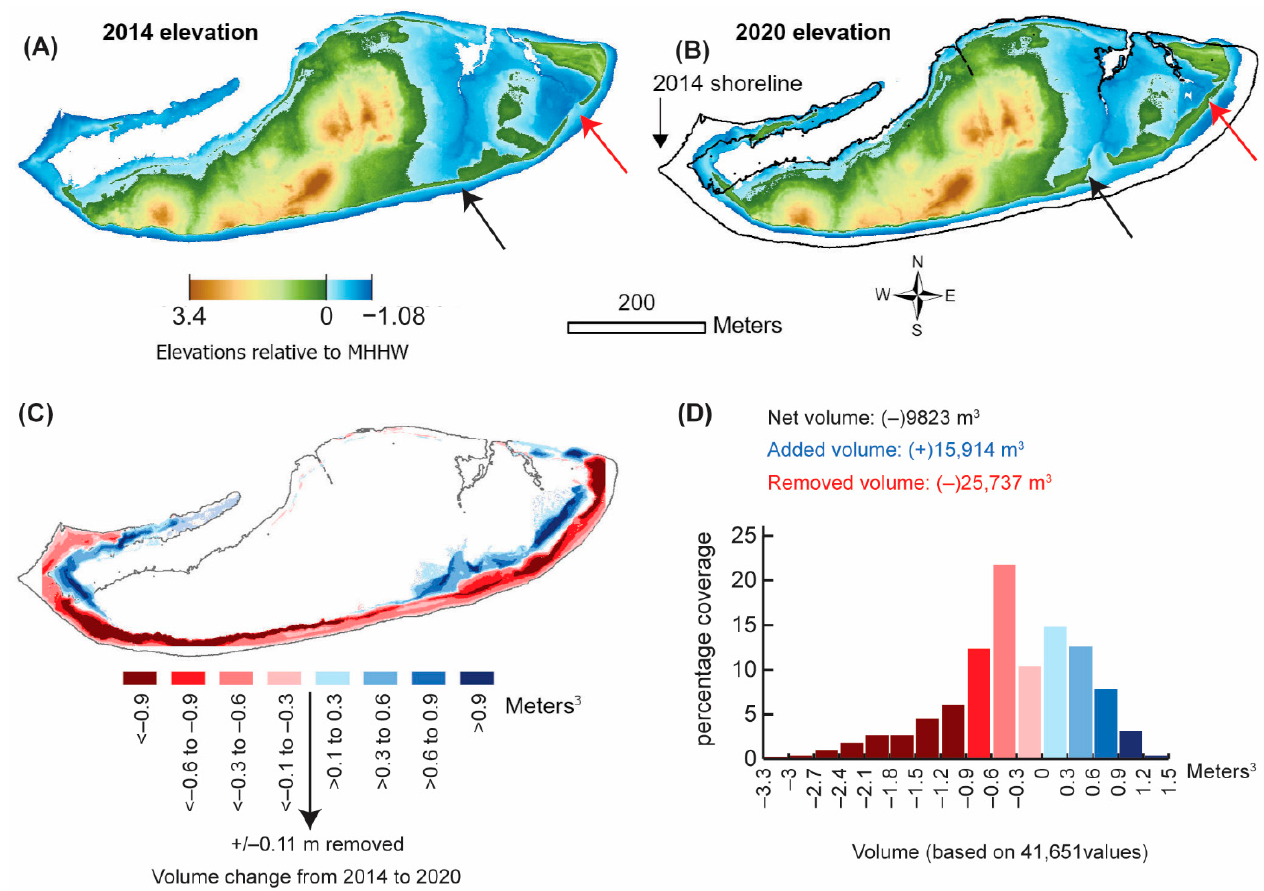
Figure 4. ( A ) 2014 DEM relative to Mean Higher High Water (MHHW); ( B ) 2020 DEM relative to MHHW, ( C ) difference of DEMs (DoD’s) where the 2014 DEM was subtracted from the 2020 DEM and spatially uniform DEM error removed (+/ − 0.11 m) to reveal morphological change as erosion (red negative values) and deposition (blue positive values), and ( D ) corresponding bar graph showing elevation change distributions. Colored arrows in ( A , B ) depict features described in the text.